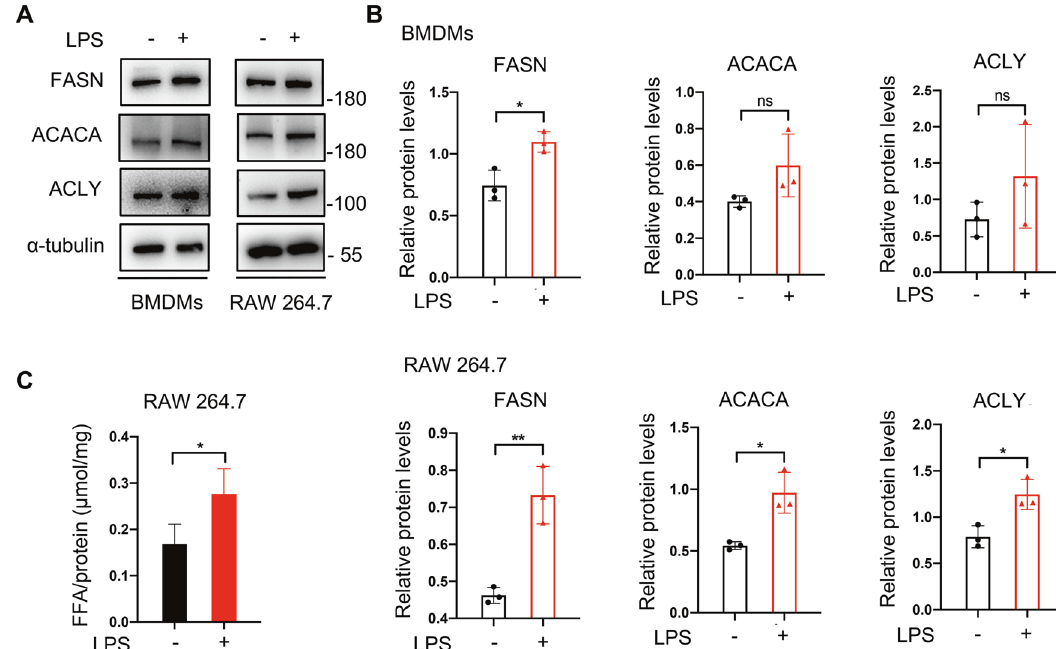
Fig. 1 LPS stimuli promoted de novo fatty acid synthesis pathway in macrophages. A , B Murine bone marrow-derived macrophages (BMDMs) or murine RAW 264.7 macrophages were cultured in the absence or presence of 100 ng/ml lipopolysaccharide (LPS). The protein levels of fatty acid synthase (FASN), acetyl-CoA carboxylase (ACACA), and ATP citrate lyase (ACLY) were determined by Western blotting. Representative images of western blotting ( A ) and a statistical analysis of relative protein levels ( B ). C The intracellular free fatty acid (FFA) was determined by free fatty acid assay kit after exposure to LPS ( n = 4). Data were all represented as means ± SD. * p < 0.05, ** p < 0.01, *** p < 0.001, **** p < 0.0001, t